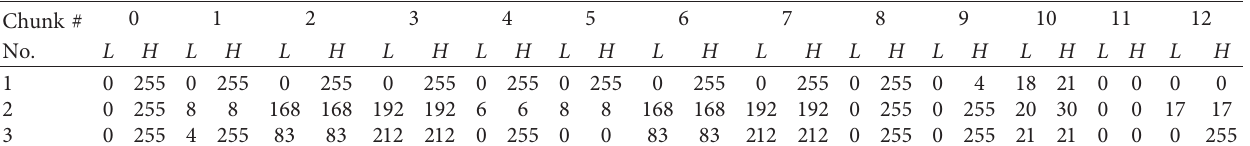
Table 3: The range format of the three rules.